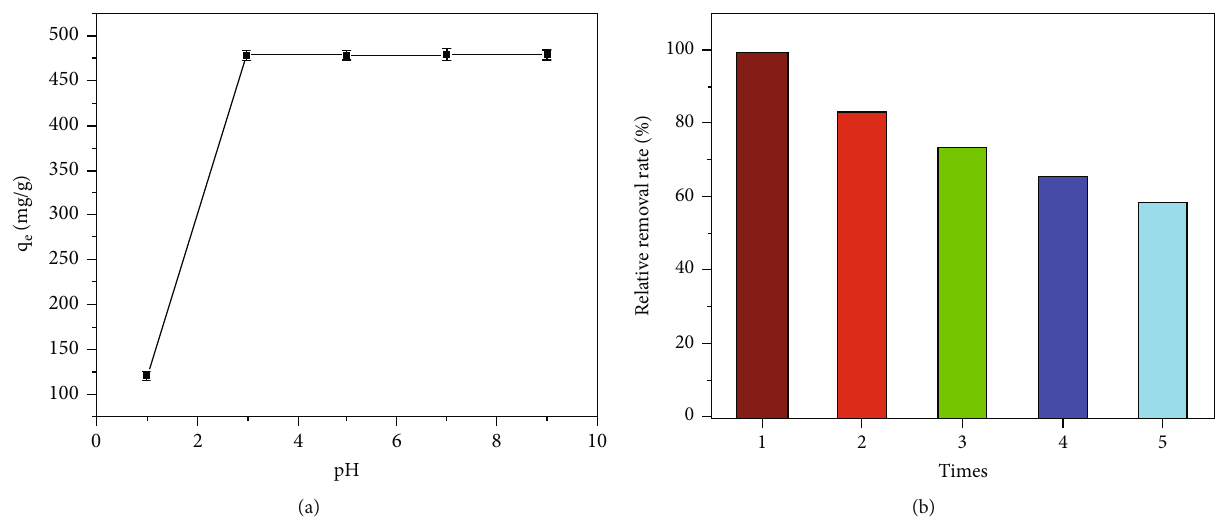
Figure 6: E ff ect of pH (a) and thermal regeneration (b) on the adsorption performance of CaFe